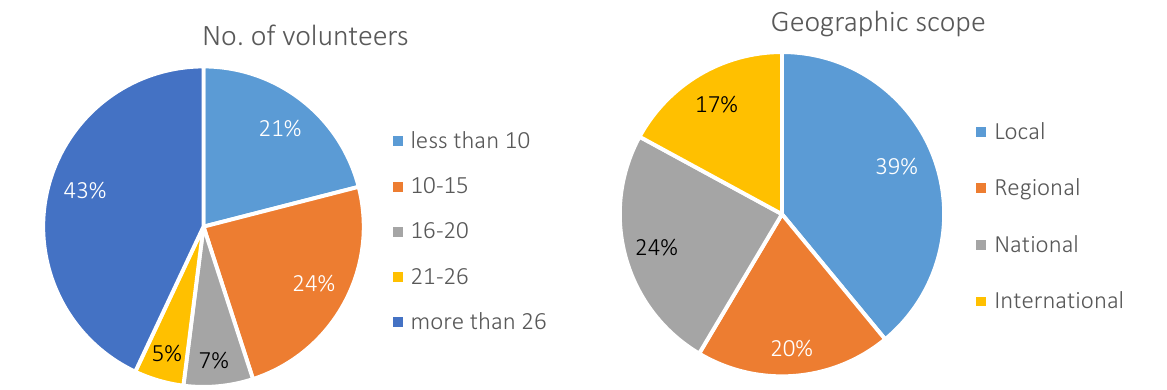
Figure 1. Organizations in the